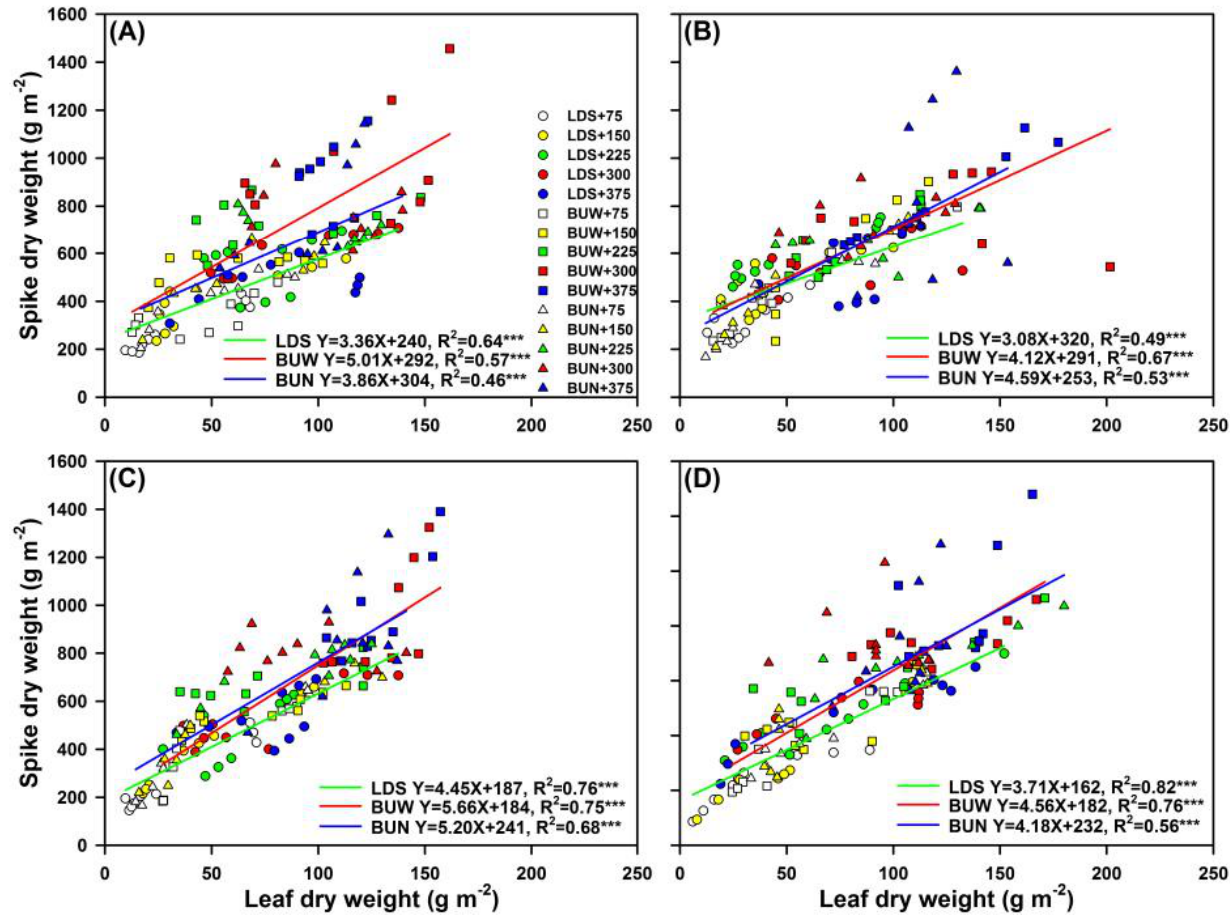
Figure 6. The ratio between the spike dry matter to leaf dry matter ( A ) Guizi 1, ( B ) Guizi 4, ( C ) Guinong 19, and ( D ) Guinong 30 under three sowing patterns (SP; line and dense sowing with 33.3 cm row spacing (LDS); belt uniform sowing with 20 cm row spacing (BUW); and belt uniform sowing with 15 cm row spacing (BUN)) and five sowing density (SD; 75, 150, 225, 300, and 375 plants m − 2 ) in the three consecutive growing seasons. *** p < 0.001.